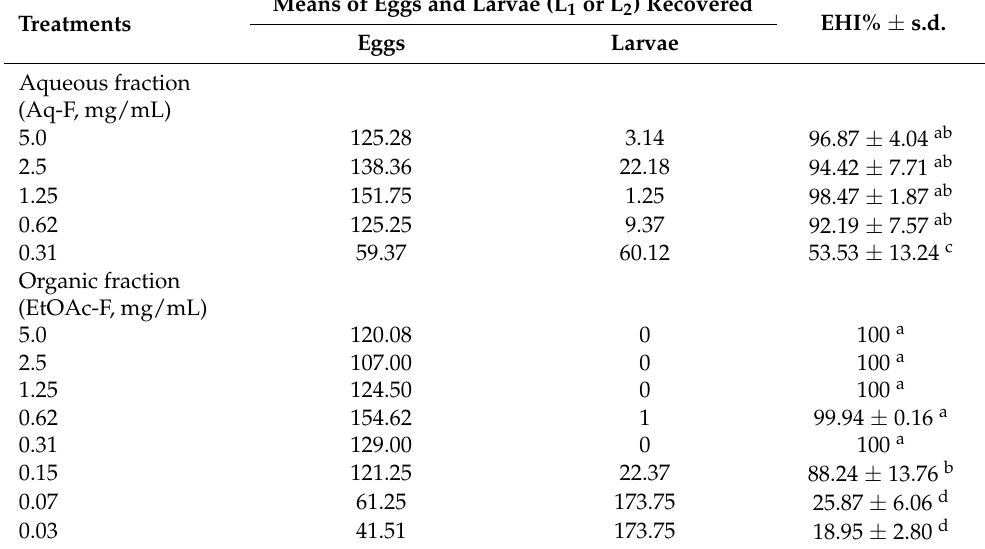
Table 1. Cont. Treatments